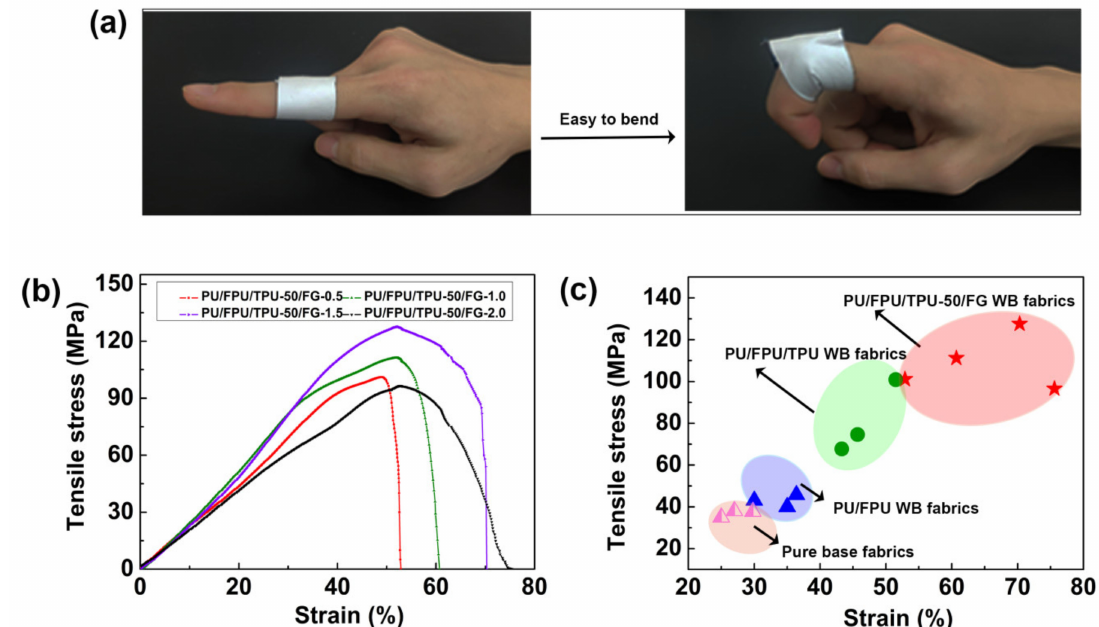
Figure 6. ( a ) Demonstration of the softness of PU / FPU / TPU-50 / FG-1.5 WB fabric. ( b ) Stress–strain curve of the PU / FPU / TPU-50 / FG WB fabrics at di ff erent FG concentrations. ( c ) Mechanical performance of pure base fabrics, PU / FPU WB fabrics, PU / FPU / TPU WB fabrics, PU / FPU / TPU-50 / FG WB